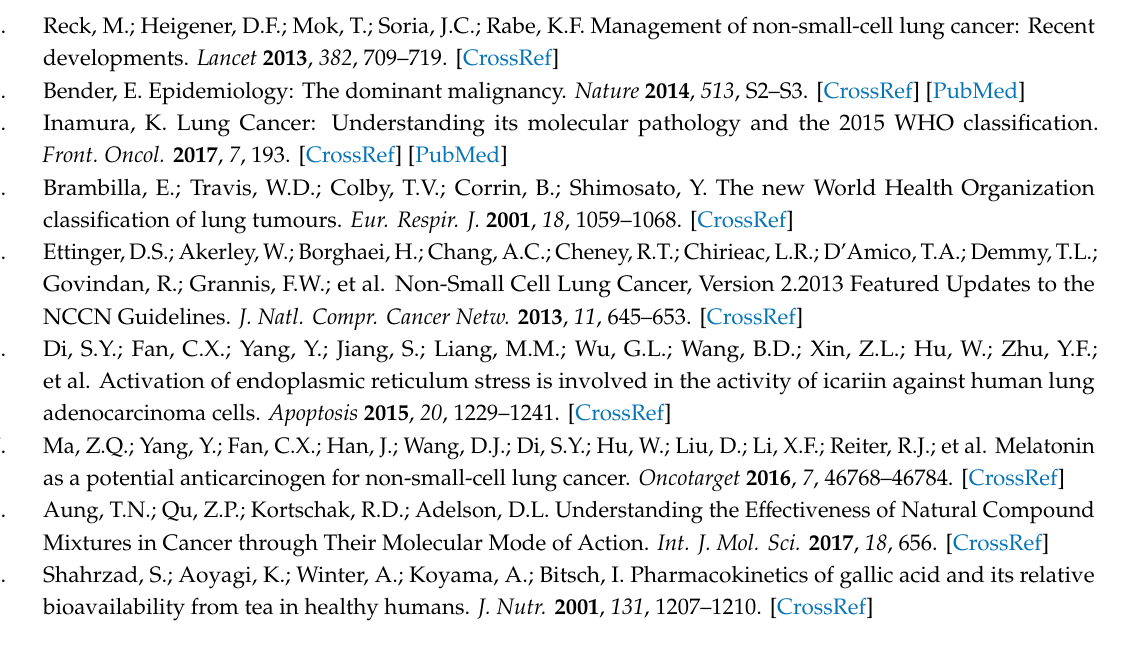
Figure S1: E ff ects of GA on A549 and H292 cell viability. (A) MTT-based evaluation of A549 and H292 cell viability in di ff erent time- and GA concentration-dependent manners. Data are representative of three independent experiments. *** p < 0.001 ( t- test). (B) A549 and H292 cell lines were treated with increasing concentration of GA for 48 h and the viability was checked using the crystal violet method. Data are representative of three independent experiments. *** p < 0.001 ( t- test). Figure S2: E ff ects of GA on Huvec cell viability. The cell survival rates of Huvec cells were examined after treatment with 400 µ M GA, anti-PD-1 mAb (5 µ g / mL), or both GA and anti-PD-1 mAb for 48 hours. Figure S3: E ff ect of GA in Jak2 / STAT3 pathway. (A) The expression levels of pSTAT3 and pJAK2 protein in A549 and H292 cells were detected after GA treatment in concentrations indicated for 48 h. Data are representative of three independent experiments. * p < 0.05 ( t- test). (B) Relative protein levels pJak2 and pSTAT3 were determined by densitometry analysis and normalized to β -actin. Data are representative of three independent